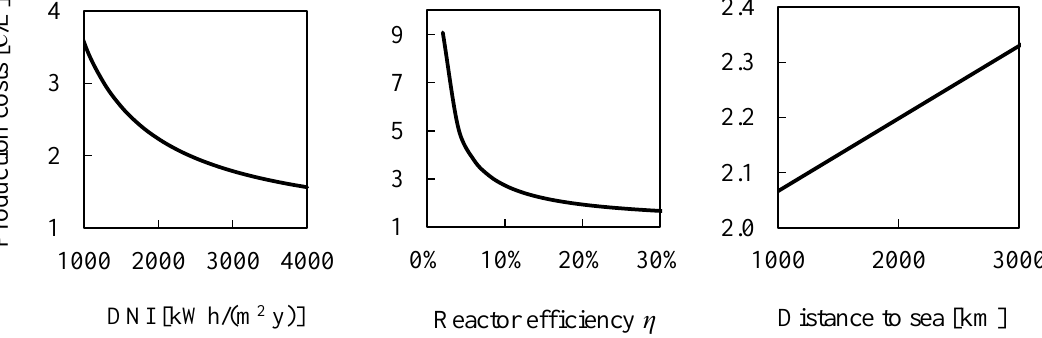
Figure 3. Production costs as a function of solar irradiation (DNI, left ), reactor efficiency ( η , center ), and distance to sea ( right ), whereas the latter determines the length of the product pipeline.